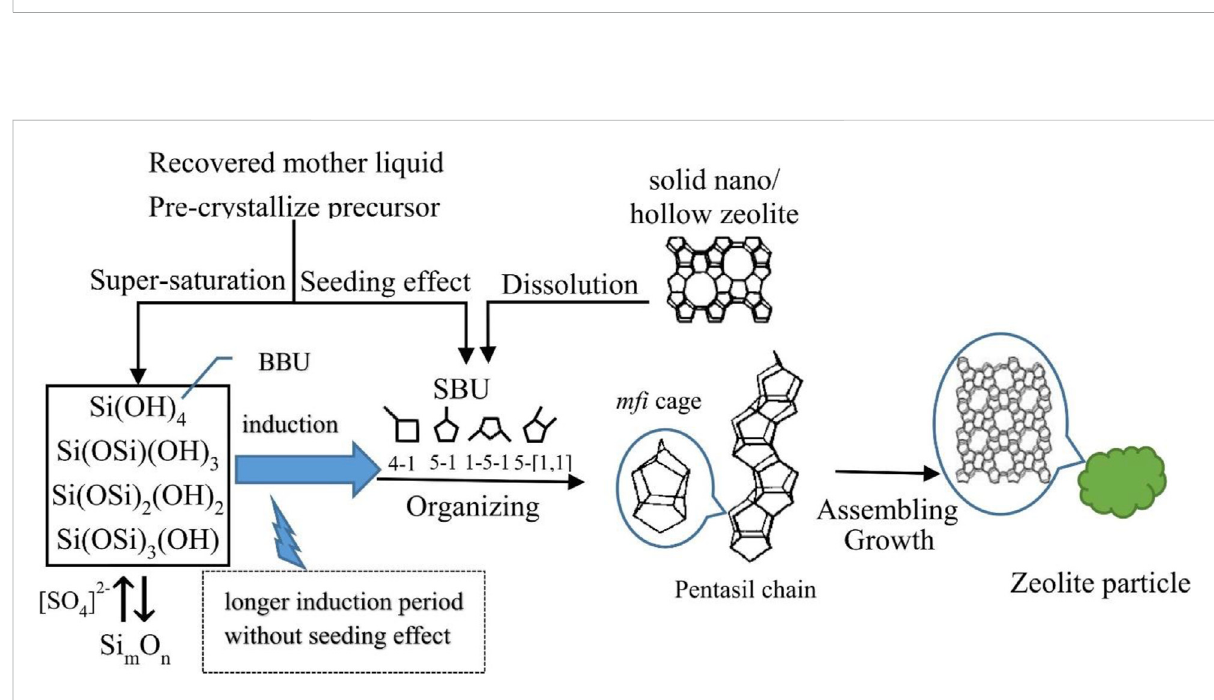
FIGURE 7 Growth model of the TS-1 zeolite (MFI-type crystal). Reprinted with permission from Liu et al. (2020). Copyright 2019